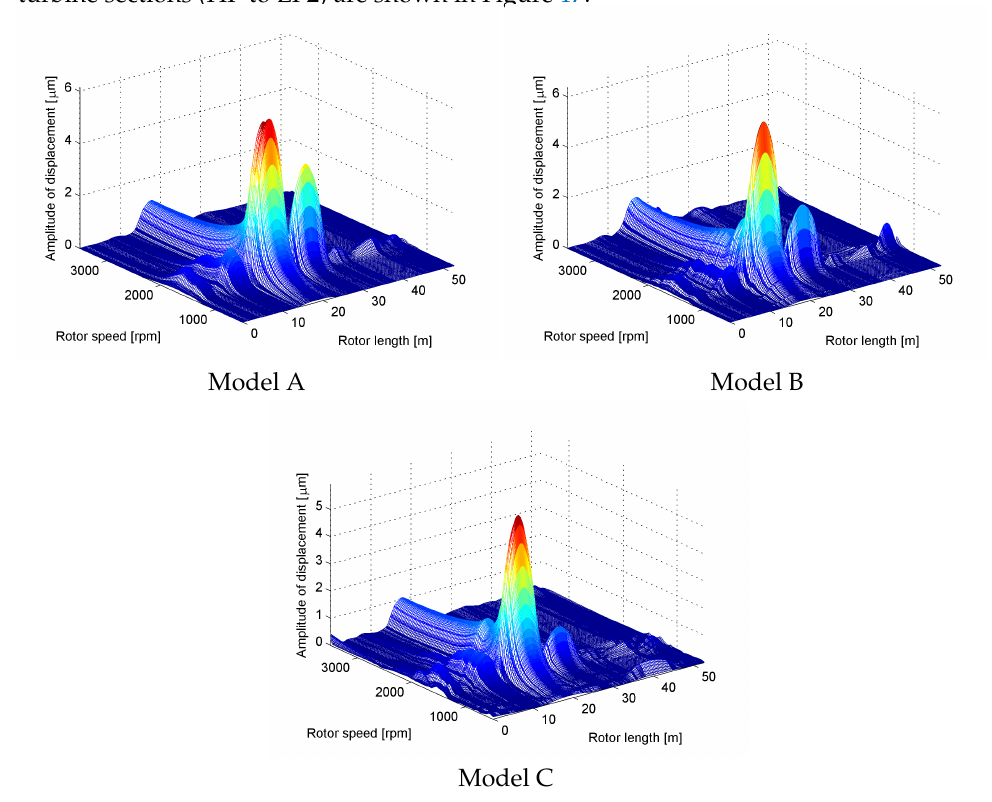
Figure 16. Absolute values of the rotor steady state complex amplitudes in the horizontal direction excited by the unbalance on the first low pressure rotor